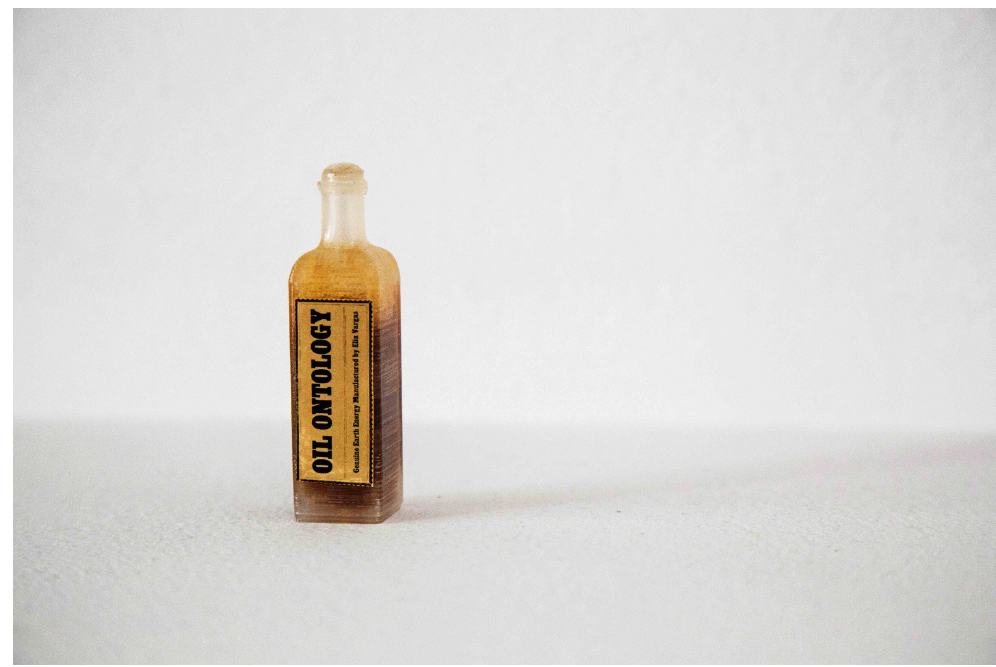
Figure 3: Oil Ontology: Genuine Earth Energy Manufactured by Elia Vargas . Photo: Elia